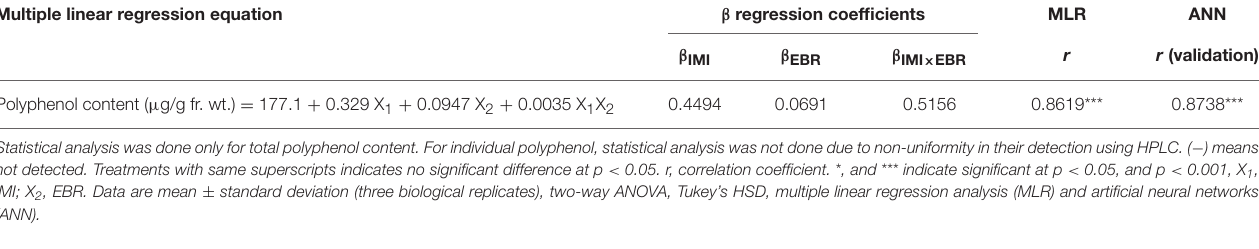
F-ratios and HSD for total polyphenol content, F IMI = 456.66***, F EBR = 34.556***, F IMI × EBR = 34.555***, HSD = 23.33* Multiple linear regression